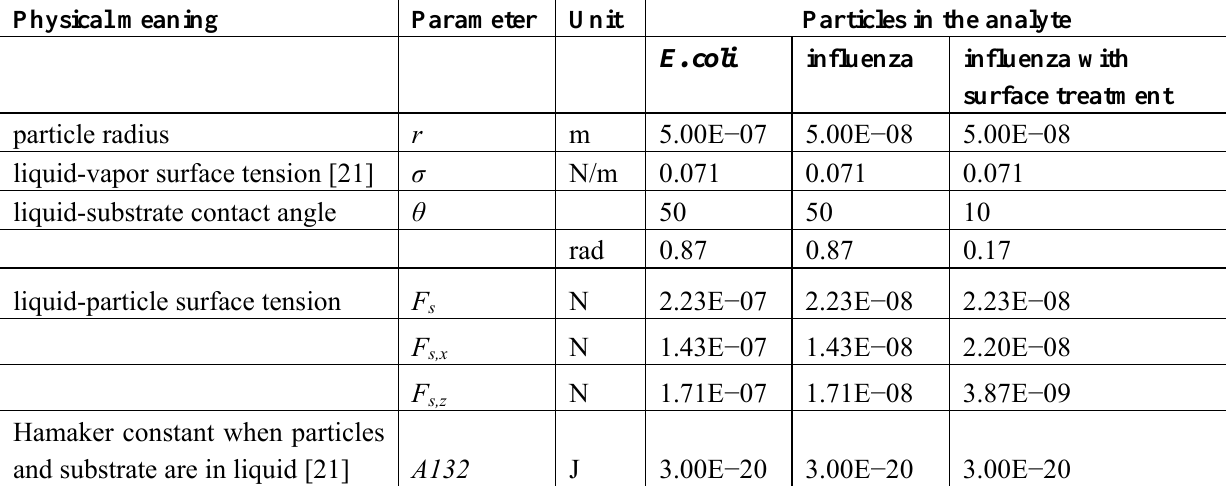
Table 1. Physical parameters, assumptions, and calculated forces used in particle motion